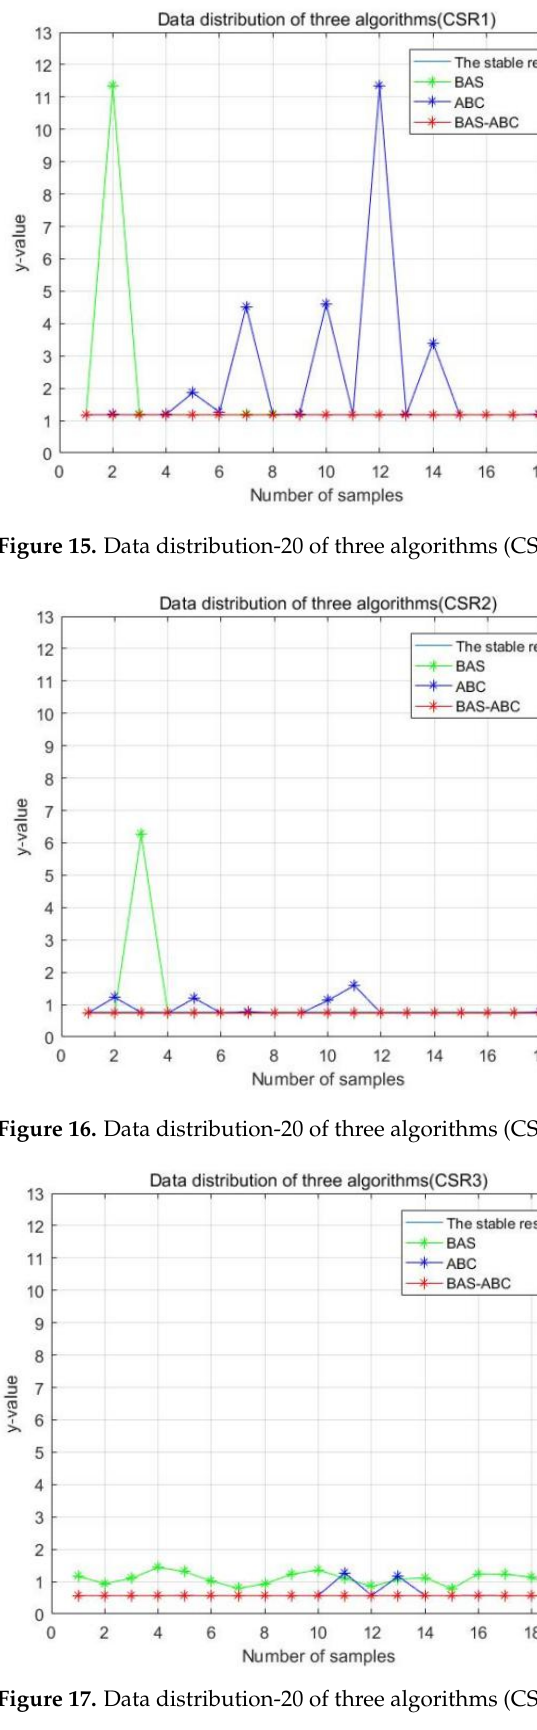
Figure 14. Data distribution-20 of three algorithms (SS3).